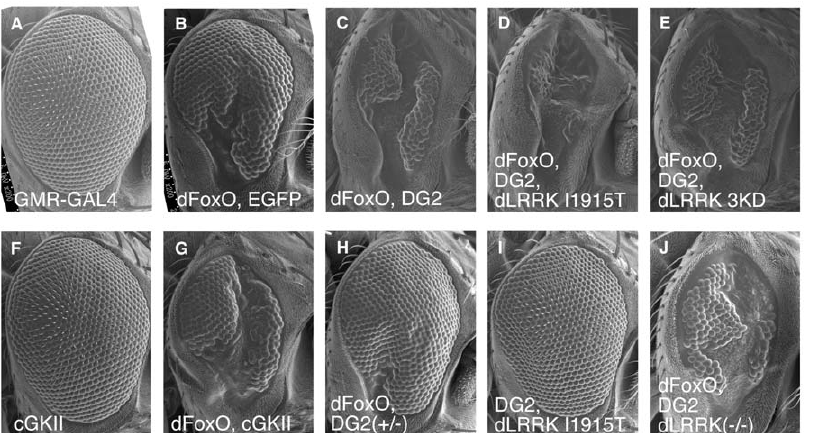
Figure 2. DG2 as well as dLRRK additively enhances FoxO-mediated developmental defects in the Drosophila eye. ( A–J ) SEM images of the eye of flies expressing the indicated genes. The genotypes are: GMR-Gal4 ( A ), GMR-Gal4/UAS-EGFP ( B ), UAS-DG2; GMR-Gal4, UAS-dFoxO ( C ), UAS-DG2;